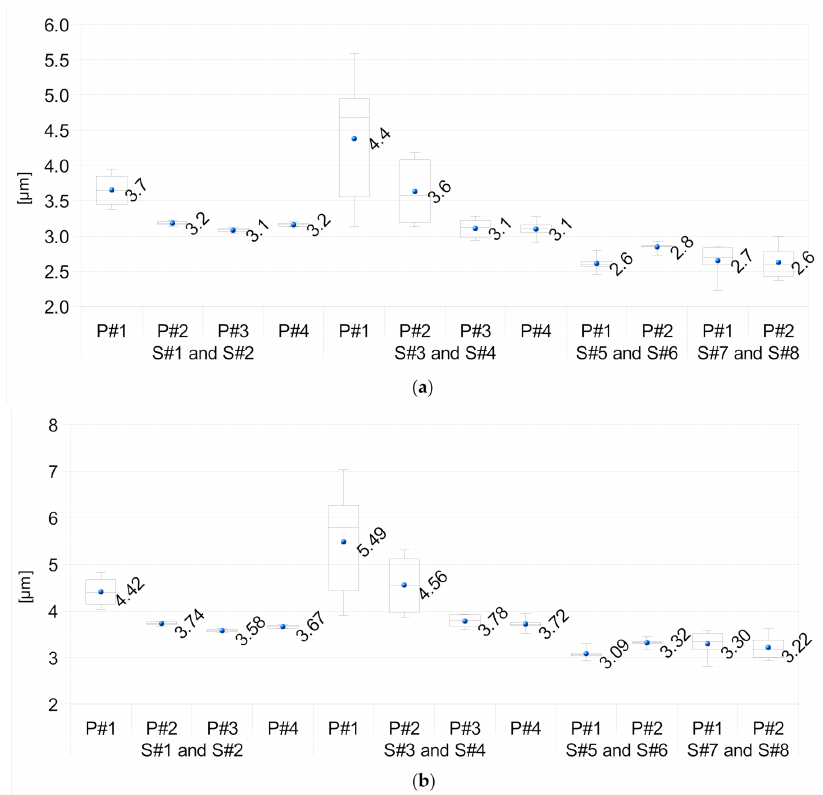
Figure 8. The center and spread of Ra ( a ) and Rq ( b ) (the box plot presents the mean, the median, the interquartile range box, and the range of the data).